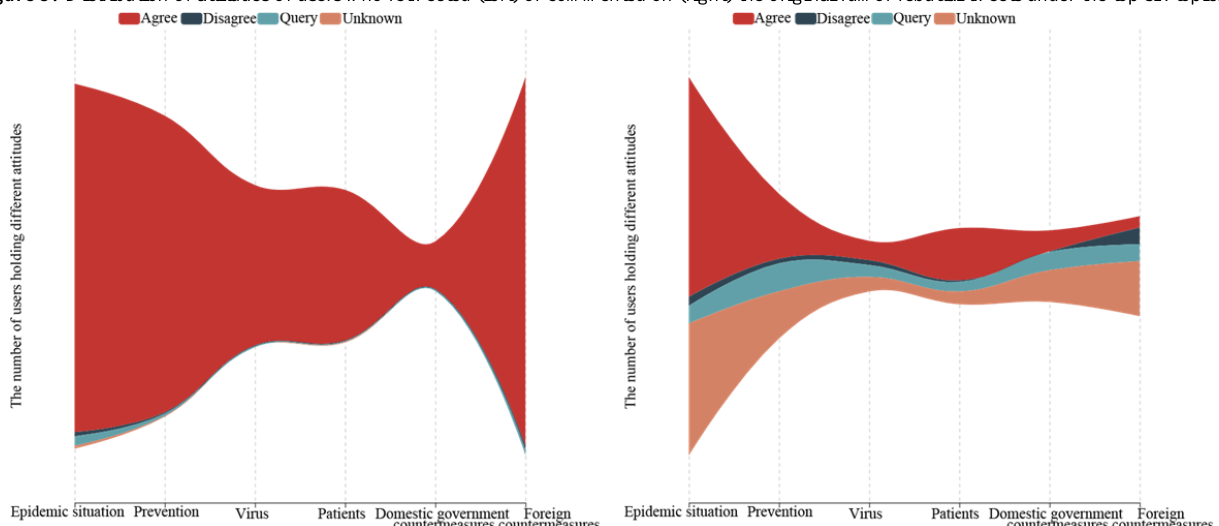
Figure 3. Distribution of attitudes of users who retweeted (left) or commented on (right) the original rumor rebuttal tweets under the top six